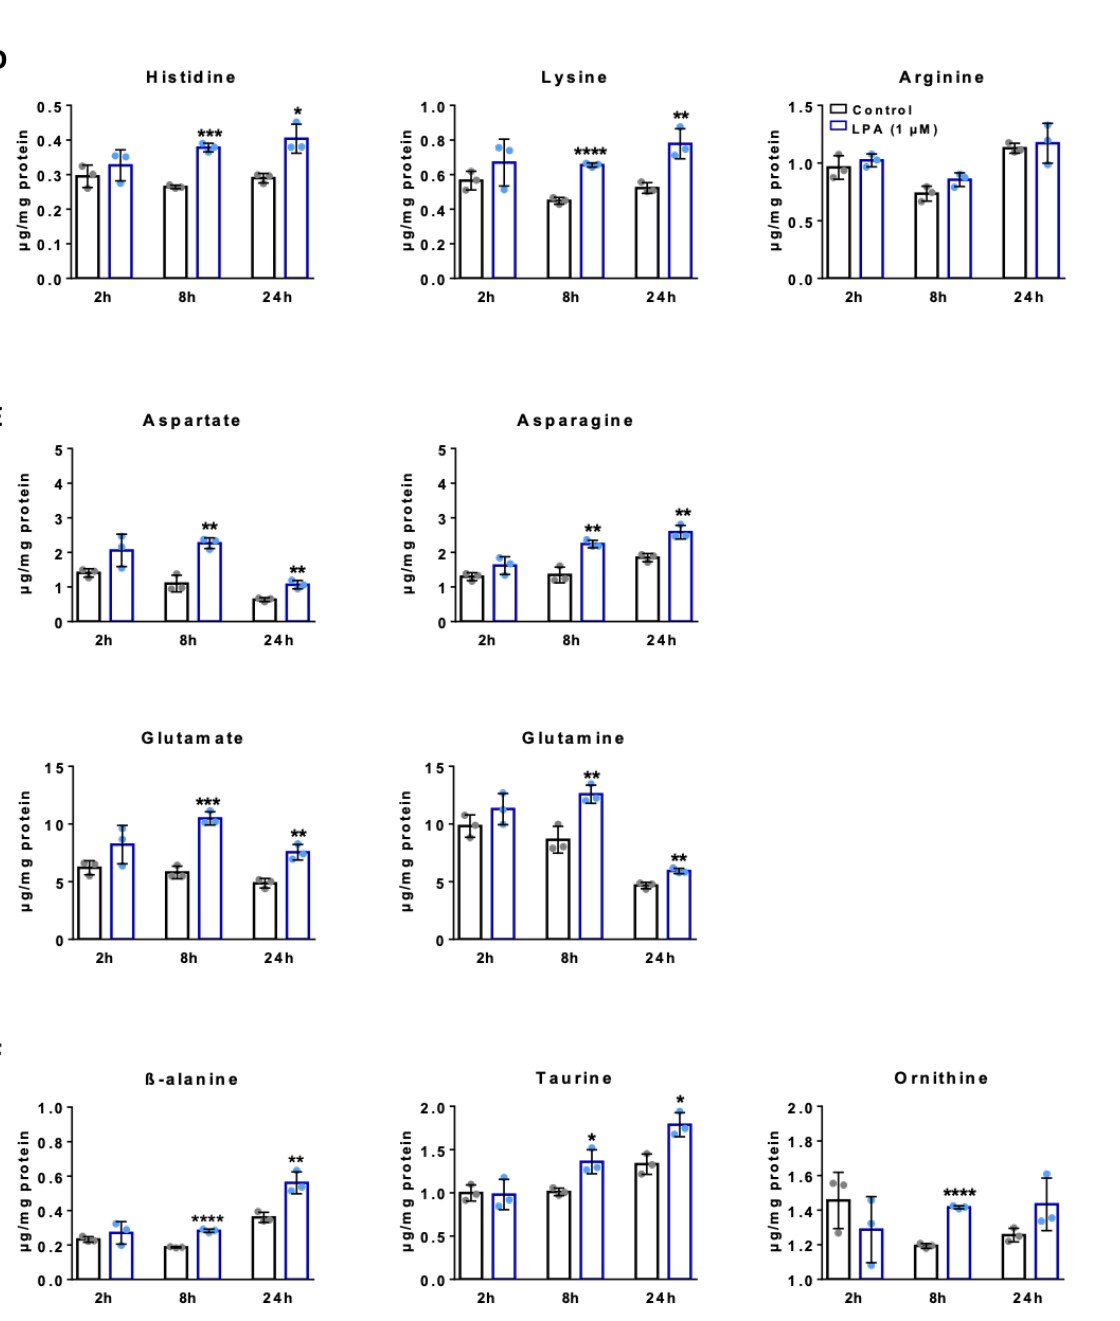
Figure 6. Amino acid analysis of LPA treated BV-2 cells. Serum-starved BV-2 cells were incubated in the absence (control) and presence of LPA (1 µ M) for the indicated times. HPLC analysis of OPA derivatized amino acids (AAs) was performed and amino acid concentrations were determined by area comparison with external calibration curves and subsequent normalization to the cellular protein content. Bar graphs indicate mean ± SEM of 3 independent experiments. (* p < 0.05, ** p < 0.01, *** p < 0.001, **** p < 0.0001 compared to controls; Student`s t-test). The amino acids are grouped according to their chemical properties in: ( A ) Aliphatic AAs, ( B ) OH- and S-containing AAs, ( C ) aromatic AAs, ( D ) basic AAs, ( E ) acidic AAs, and ( F ) non-proteogenic AAs.